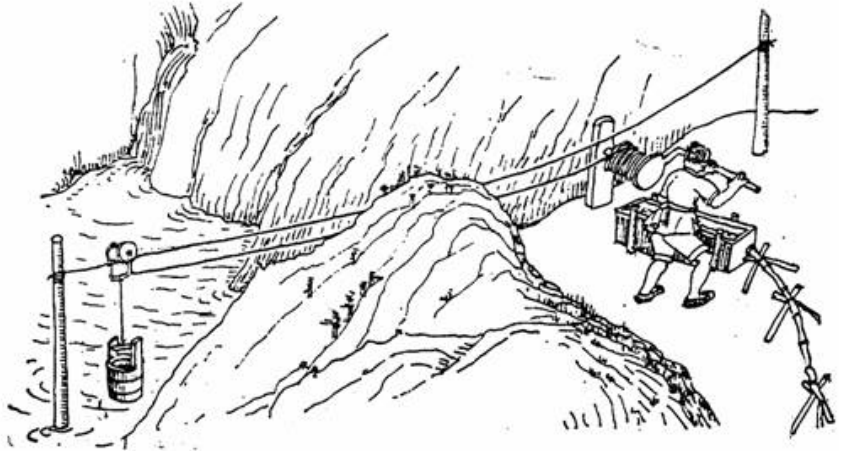
Figure 8. A sketch of J ī jí